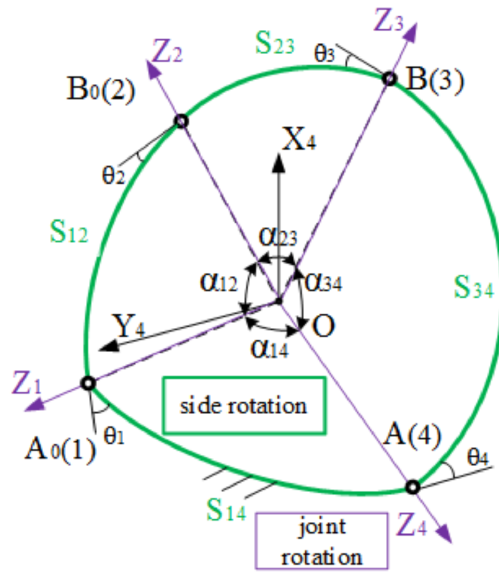
Figure 3. Joint rotation and side rotation established in a spherical four-bar manipulator with only R